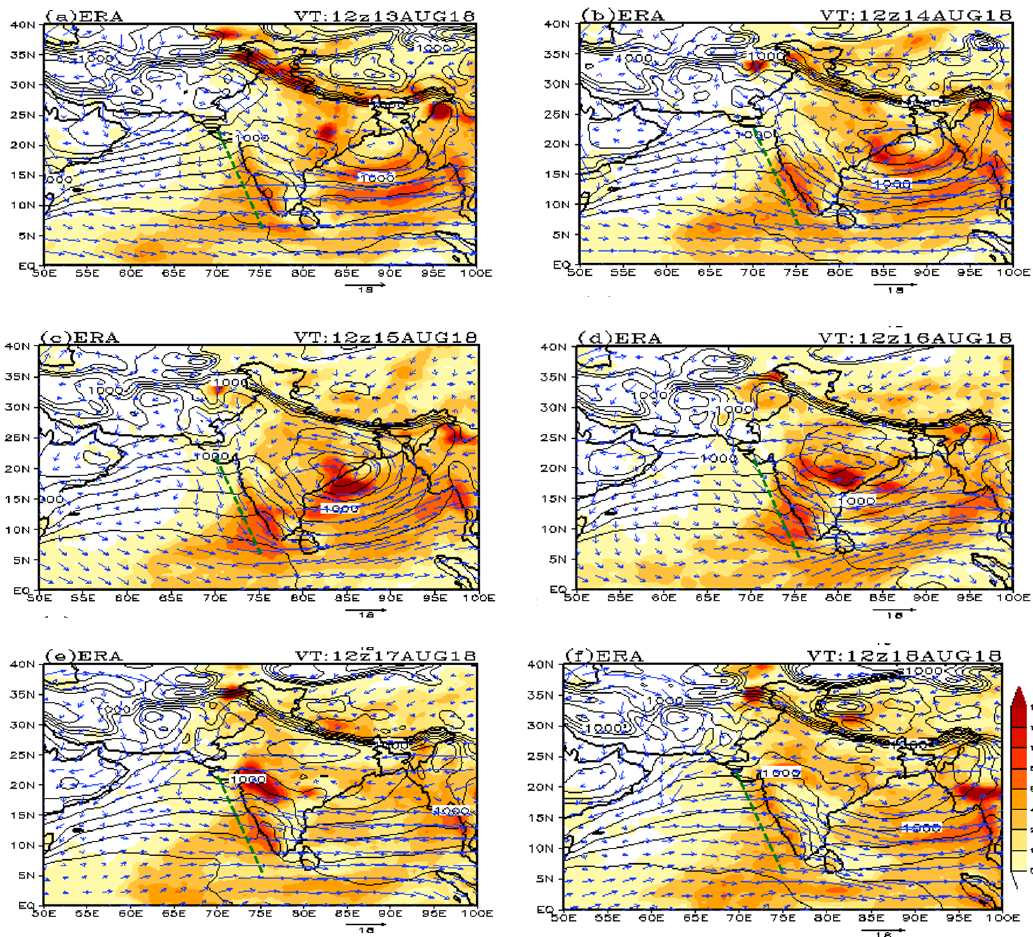
Figure 2. Accumulated total rainfall (shaded; mm · d − 1 ), mean sea level pressure (contours), and wind flow pattern at the 600 hPa level valid at 00 UTC on ( a ) 13 August, ( b ) 14 August, ( c ) 15 August ( d ) 16 August, ( e ) 17 August, and ( f ) 18 August 2018 derived from ERA-Interim reanalysis at 25 km resolutions. Dashed green lines indicate the position of the o ff shore